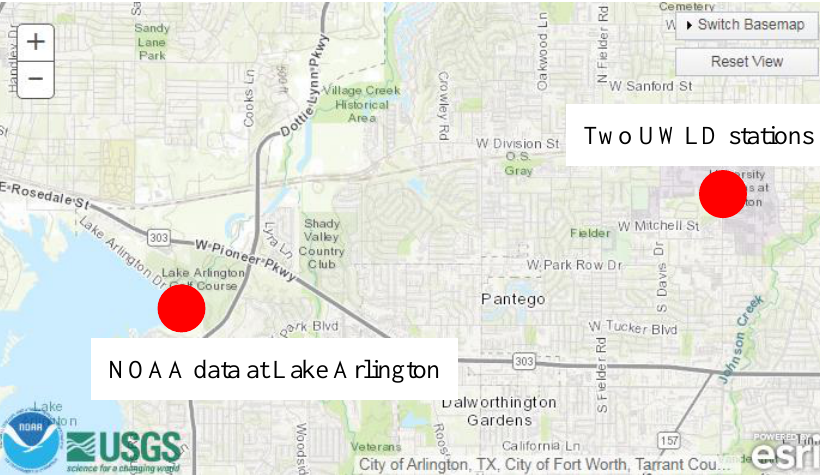
Figure 14. Map of the water level monitoring locations by NOAA and UWLD system. Lake Arlington is the closest gauge location, which is operated by NOAA, located in north Texas.